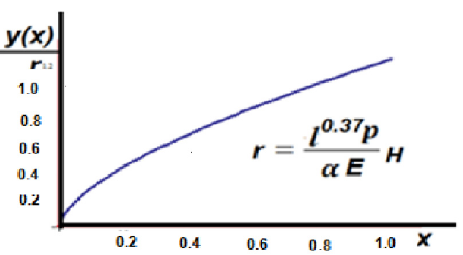
The left Λ -fractional displacement of the Cantor rod is shown in Figure 26.